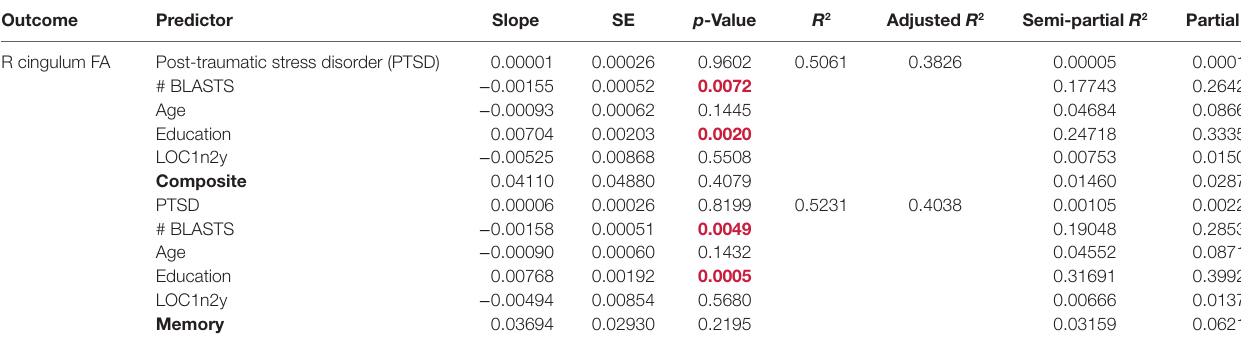
p-values in red are significant at p < 0.05 level.